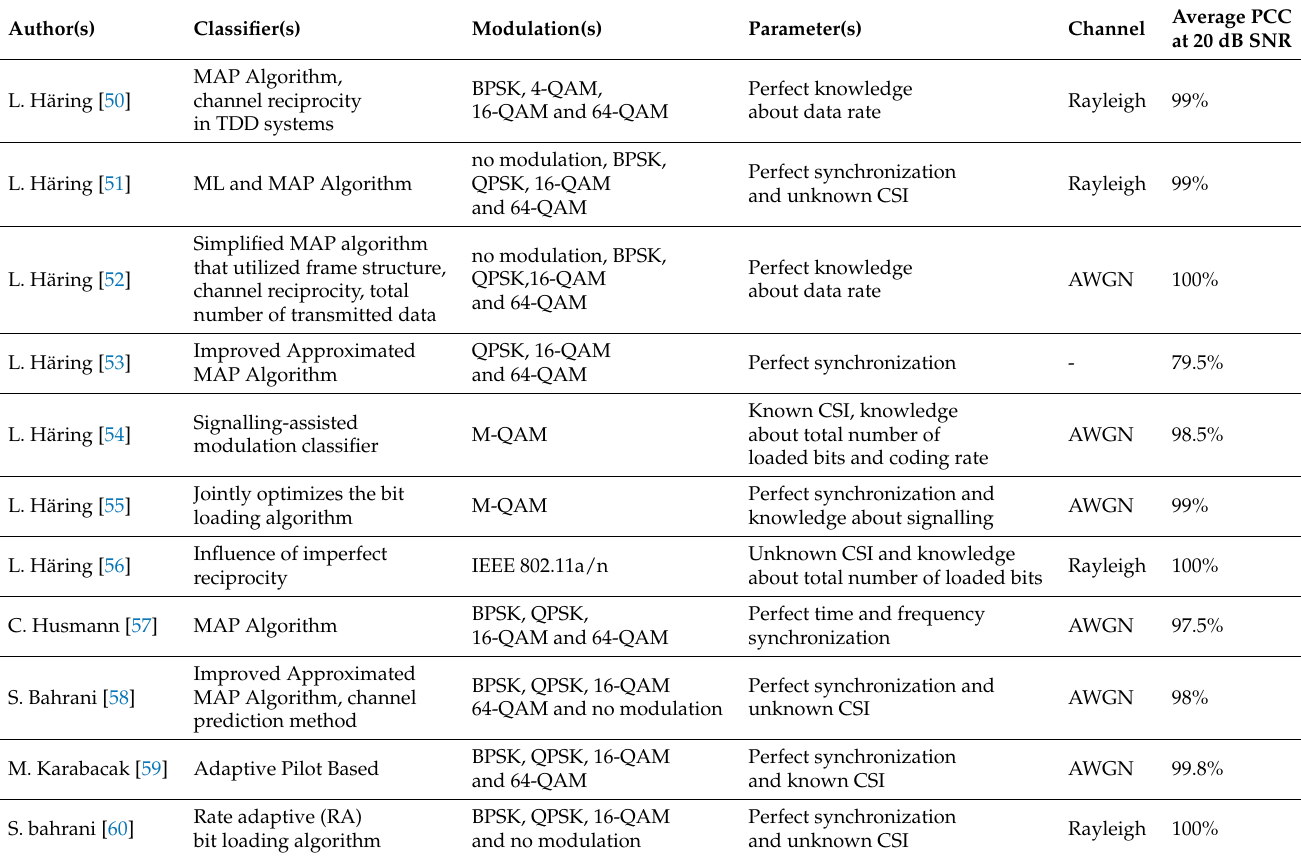
Table 3. Summary of maximum a posteriori (MAP) based classifiers for OFDM